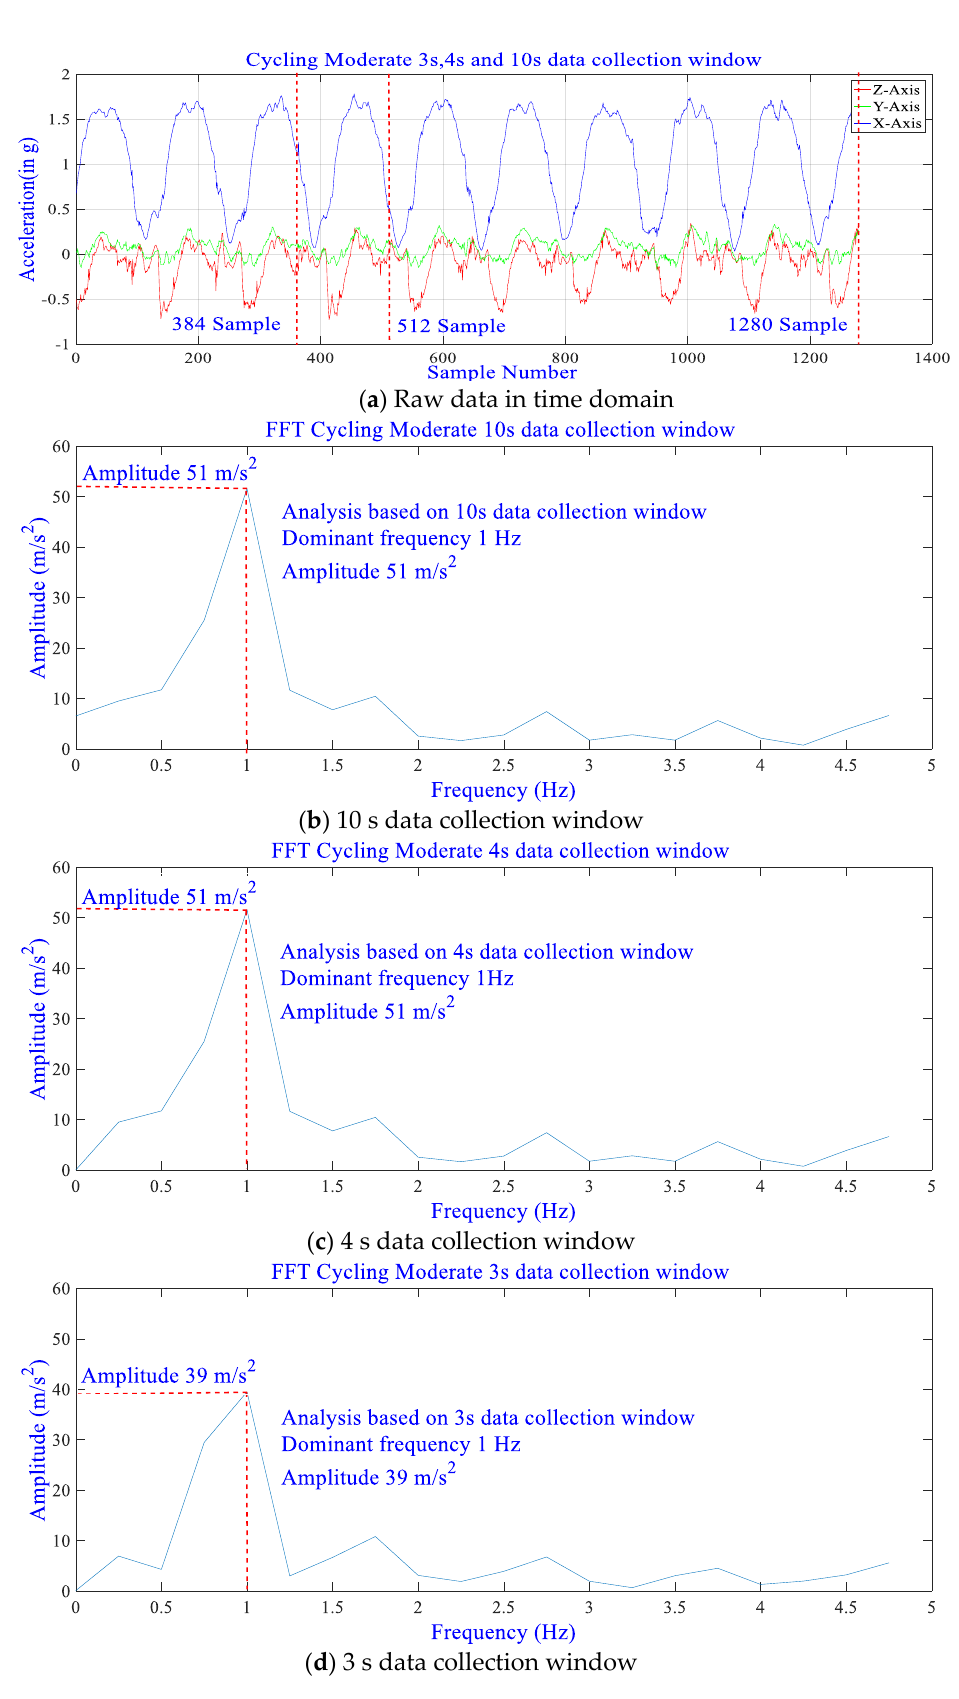
Figure 4. The outcomes of the fast Fourier transform (FFT) technique used to identify the dominant frequency and associated acceleration from 10, 4, and 3 s data collection